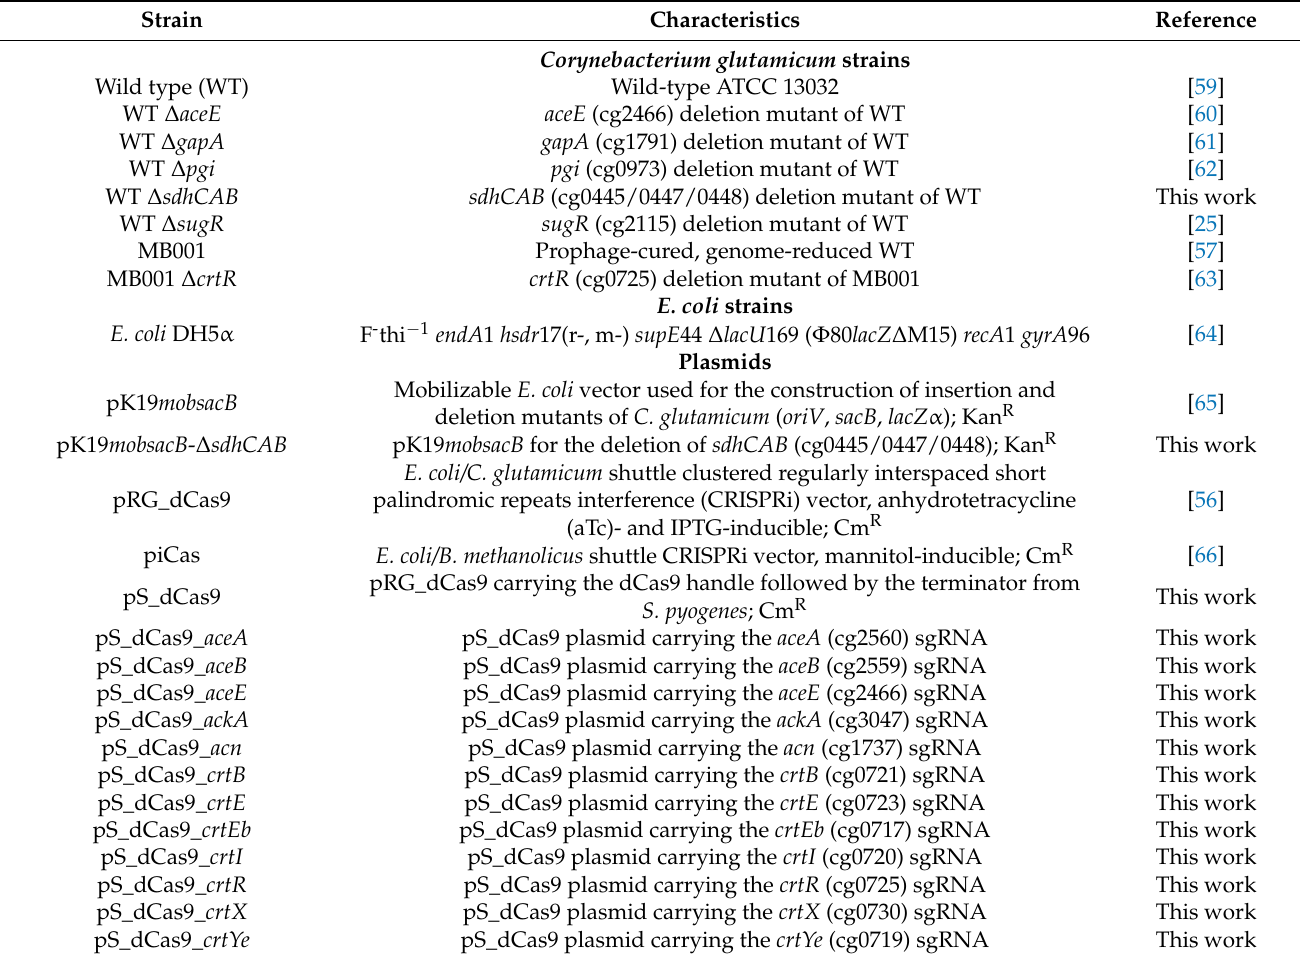
Table 1. Strains and plasmids used in this